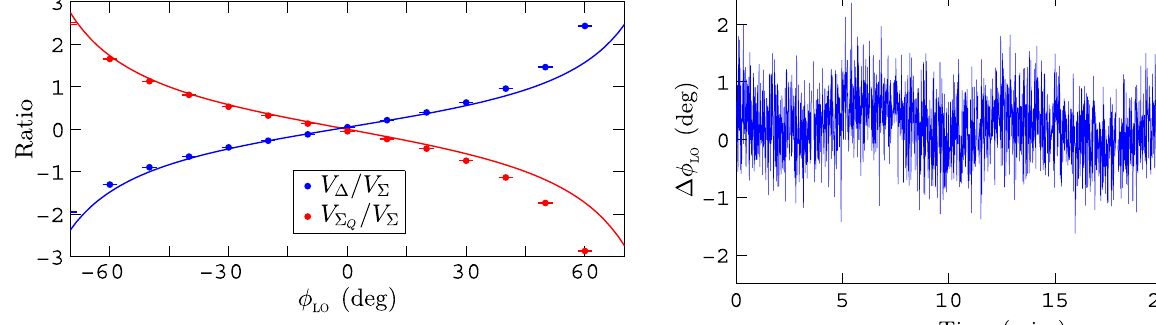
FIG. 12. Illustrative measured ratios V Δ =V Σ and V Σ LO signal phase ϕ (degrees of 714 MHz); 50 pulses are LO averaged at each phase setting. The lines show the functions in Eqs. (19) and (20); the V Δ =V Σ prediction was normalized to the ¼ 0 . data point at ϕ LO